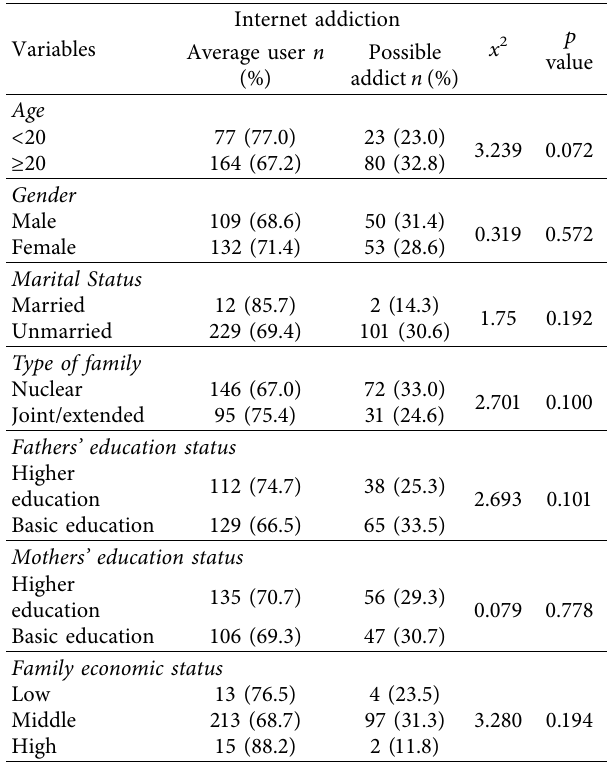
Table 4: Internet addiction and its association with sociodemo- graphic